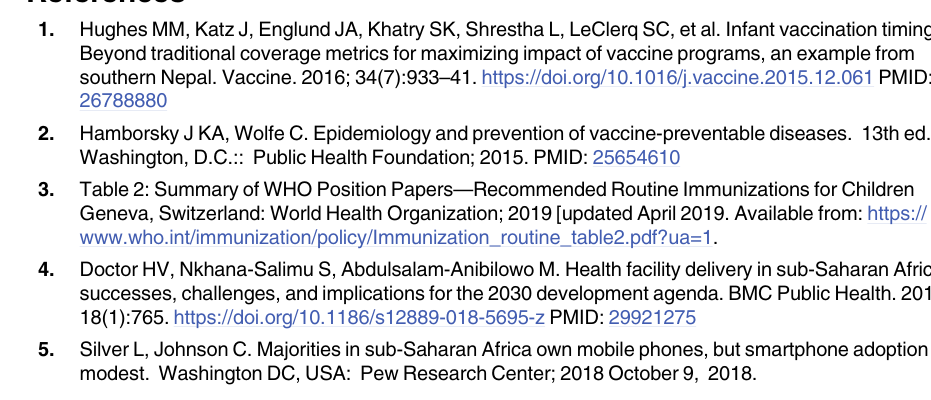
S4 Table. On-time coverage of infant vaccinations in GEVaP intervention and control communities (N =